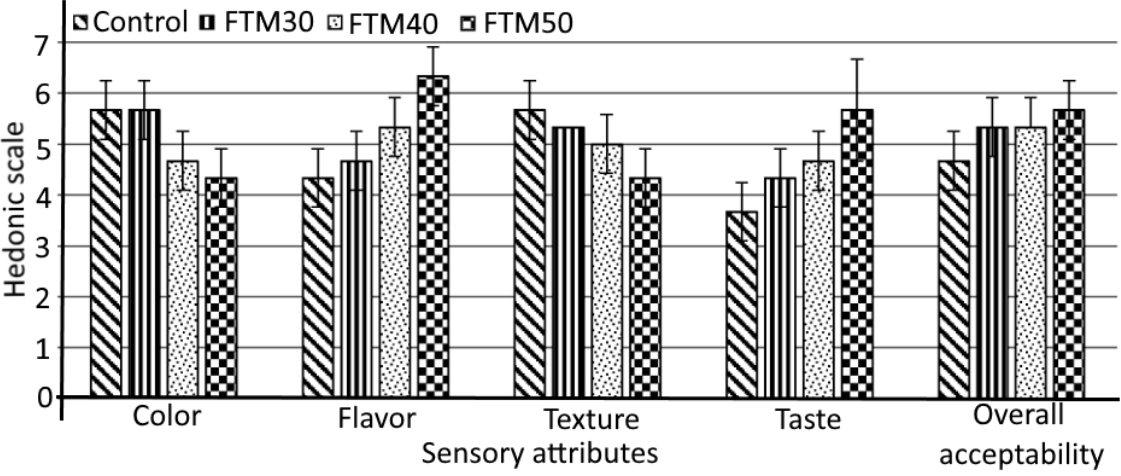
Figure 1. Sensory attributes of foxtail millet noodles. Results are expressed as mean values of 15 independent determinations. Mean values followed by error bars represent the standard deviation from the mean value. FTM, foxtail millet. For sample codes, refer to Table 1.